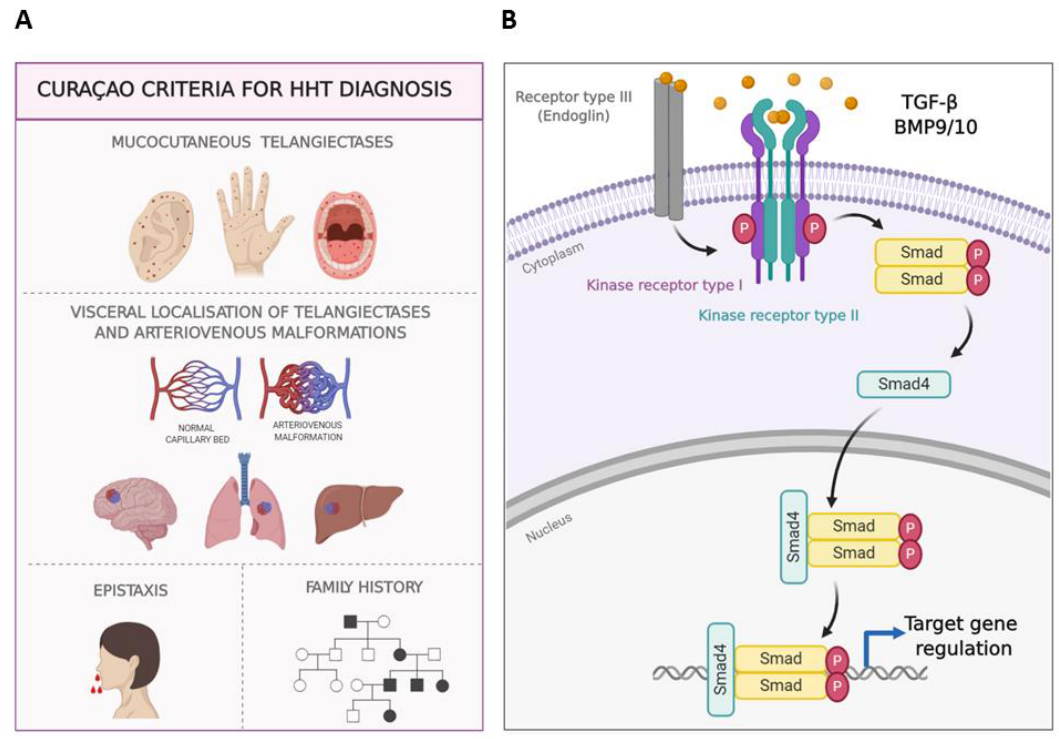
Figure 1. Hereditary Hemorrhagic Telangiectasia. ( A ). Clinical manifestations of HHT, Curaçao criteria. Telangiectasias in ear, hands, tongue, and lips; arteriovenous malformations in internal organs, epistaxis and family history. ( B ). TGF- β / BMP9 / 10 signaling pathway in endothelial cells. Once the ligand binds to its receptor complex formed by the kinase receptors I and II, and the auxiliary receptor III (endoglin), the signaling cascade leads to the phosphorylation of Smad proteins. The translocation of the Smad protein complex into the nucleus results in transcriptional regulation on target genes. Endothelial cells (EC) express two types of type I kinase Receptors: ALK1 and ALK5.